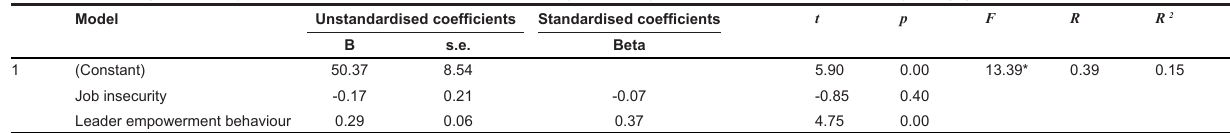
TABLE 2 s of the scales